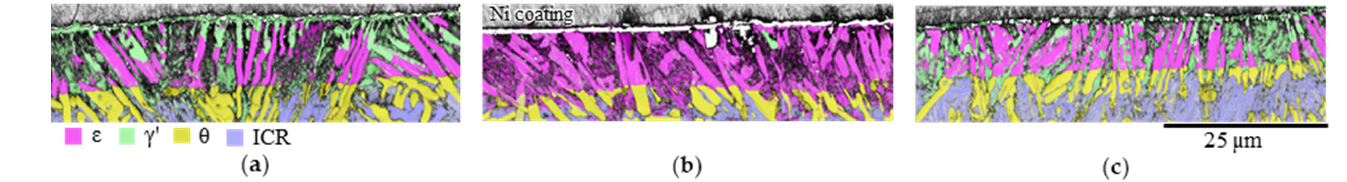
Figure 7. Cross-sectional EBSD phase maps of compound layers formed after nitriding at 540 °C for 16 h and K N = 1 atm − 1/2 of Fe-3.5C-3Si- Me model alloys with: ( a ) 1 wt% Cu; ( b ) 1 wt% Mn; ( c ) 1 wt% Mn + 1 wt% Cu [11].